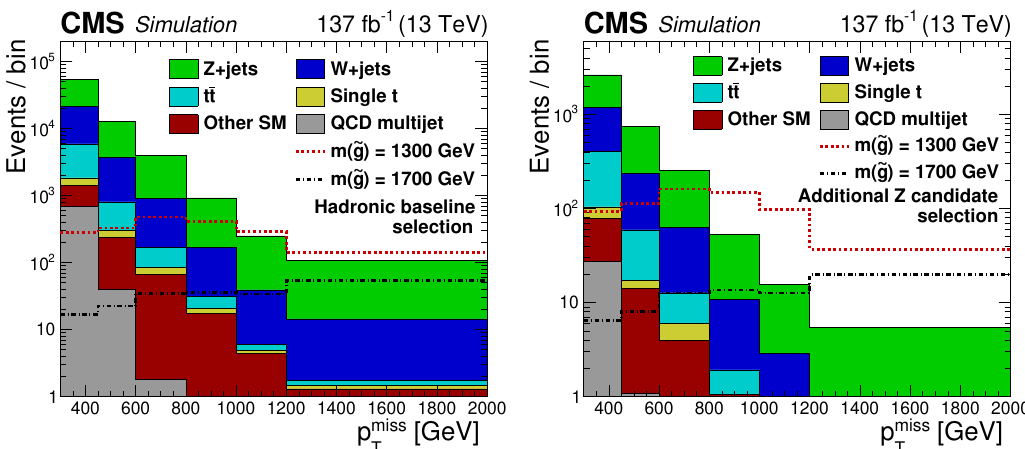
Figure 2 . Distributions of p miss for simulated SM backgrounds (stacked histograms), with only the T hadronic baseline selection (left), and after the additional Z candidate selection (right). Expected signal contributions for two example mass points (dotted lines) are also shown. The last bin includes the over(cid:13)ow